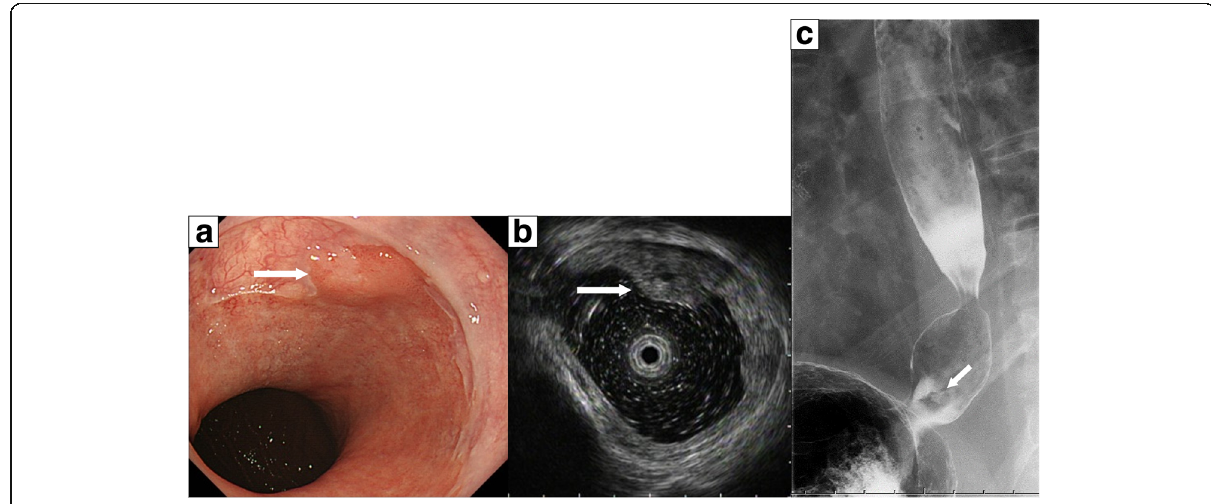
Fig. 1 Images obtained before surgery. a Endoscopy shows a sliding hiatal hernia and an approximately 10 mm elevated mass at the esophagogastric junction. b Endoscopic ultrasonography shows a mass having mixed echogenicity in the esophageal wall, with partial invasion of the submucosal layer. c Upper gastrointestinal imaging shows an elevated lesion at the esophagogastric